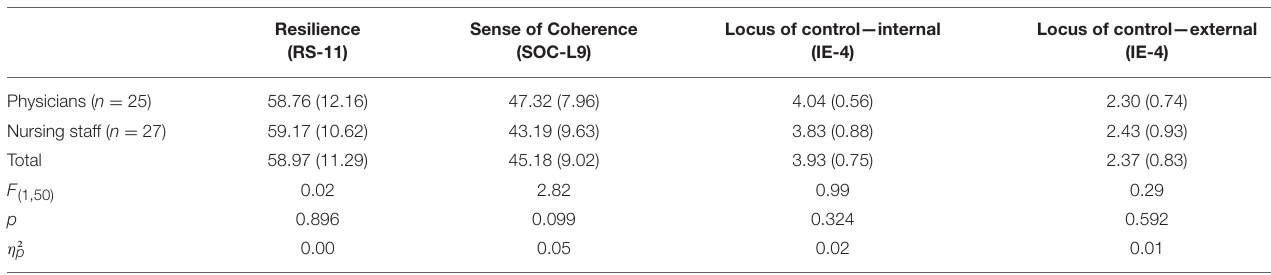
TABLE 3 | Mean scores and standard deviations for resilience, SOC and LOC.